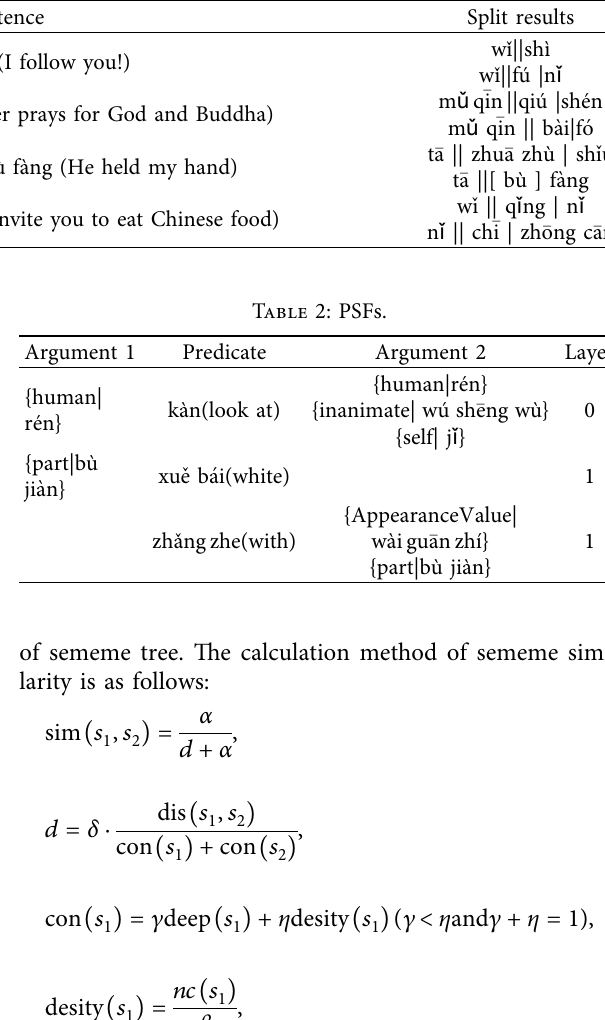
Table 1: The split methods of multipredicates.